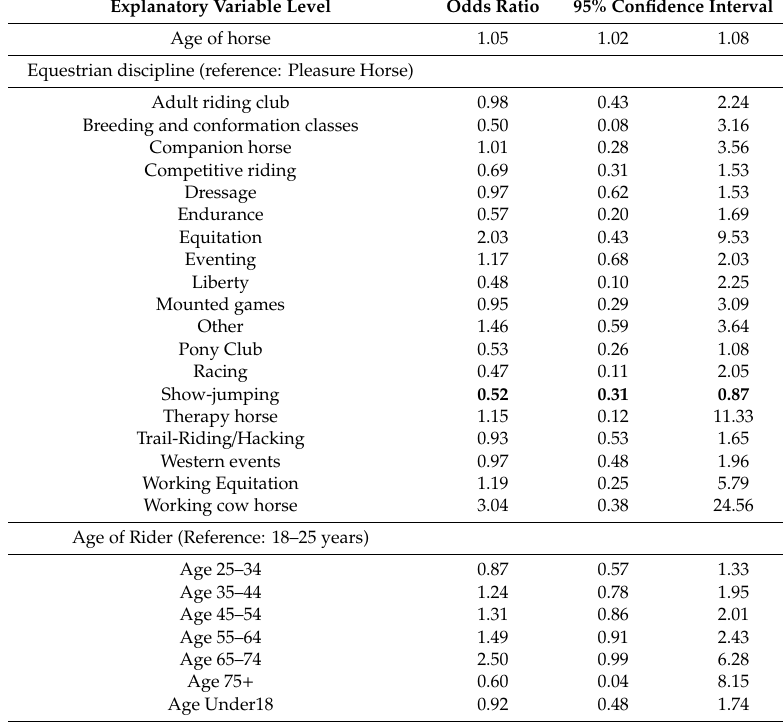
Equestrian discipline (reference: Pleasure